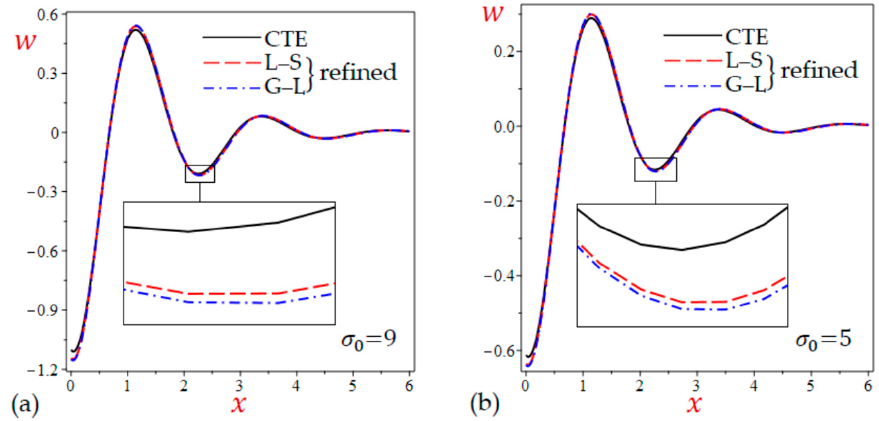
out initial pressure ( 𝓅 = 0 ) ( a ) 𝜎 (cid:2868) = 9 ; ( b ) 𝜎 (cid:2868) = 5 .